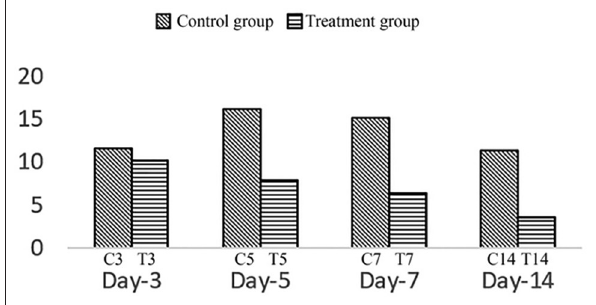
Figure-2: The cyclooxygenase-2 expression in control groups and treatment groups on day 3, 5, 7, and